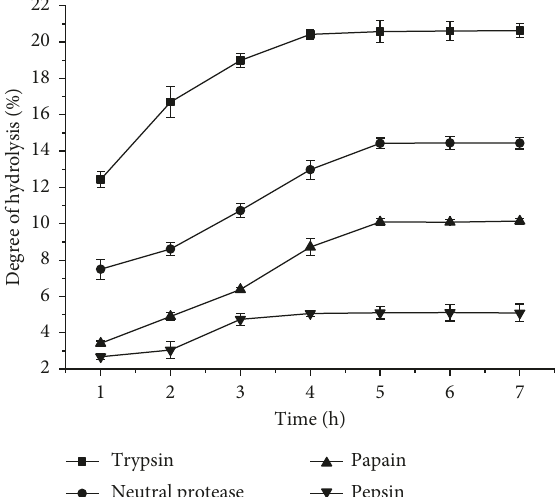
Figure 2: The degree of hydrolysis (DH) of yak skin gelatin hydrolysates by different enzymes at 2000U/g and hydrolysis times. Results are displayed as average ± standard deviations from three